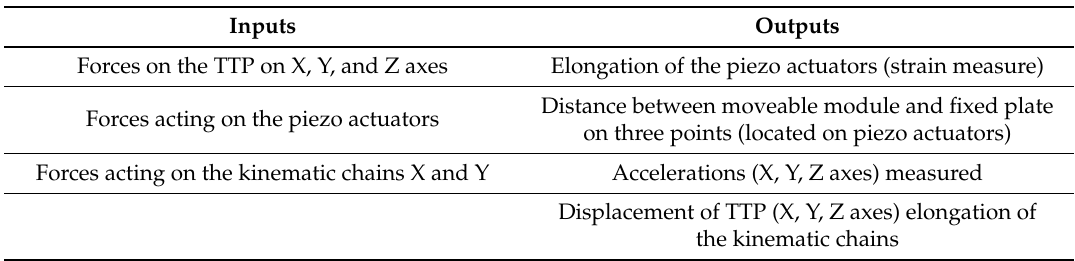
Table 4. State space model